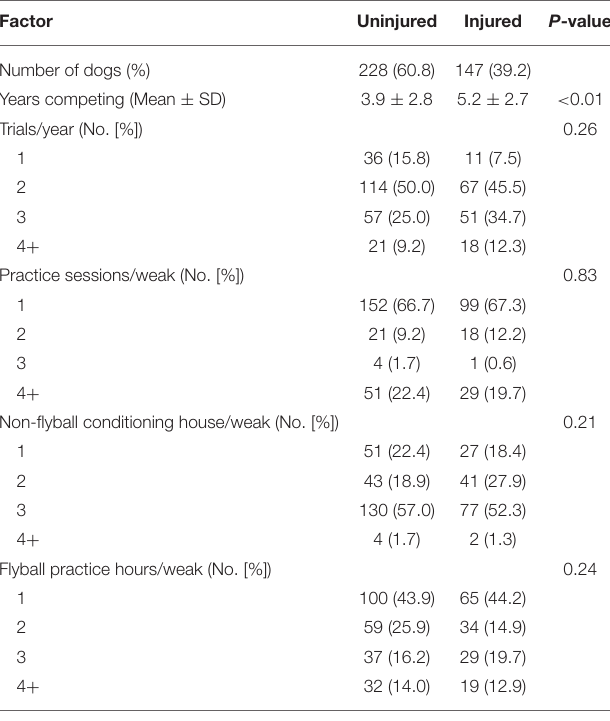
TABLE 3 | Univariate analysis assessing practice and competition frequency vs. injury status.